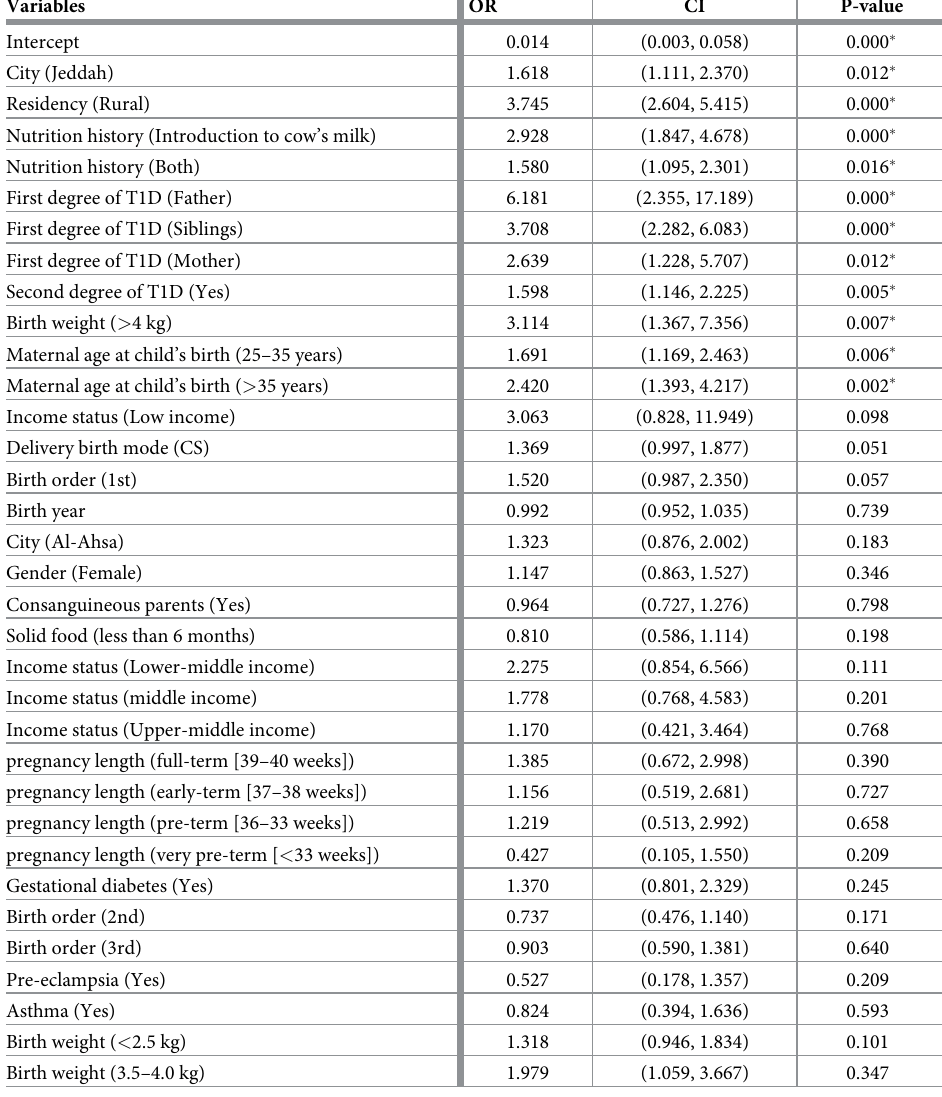
Table 4. Risk factors of T1D in children based on the logistic regression model.